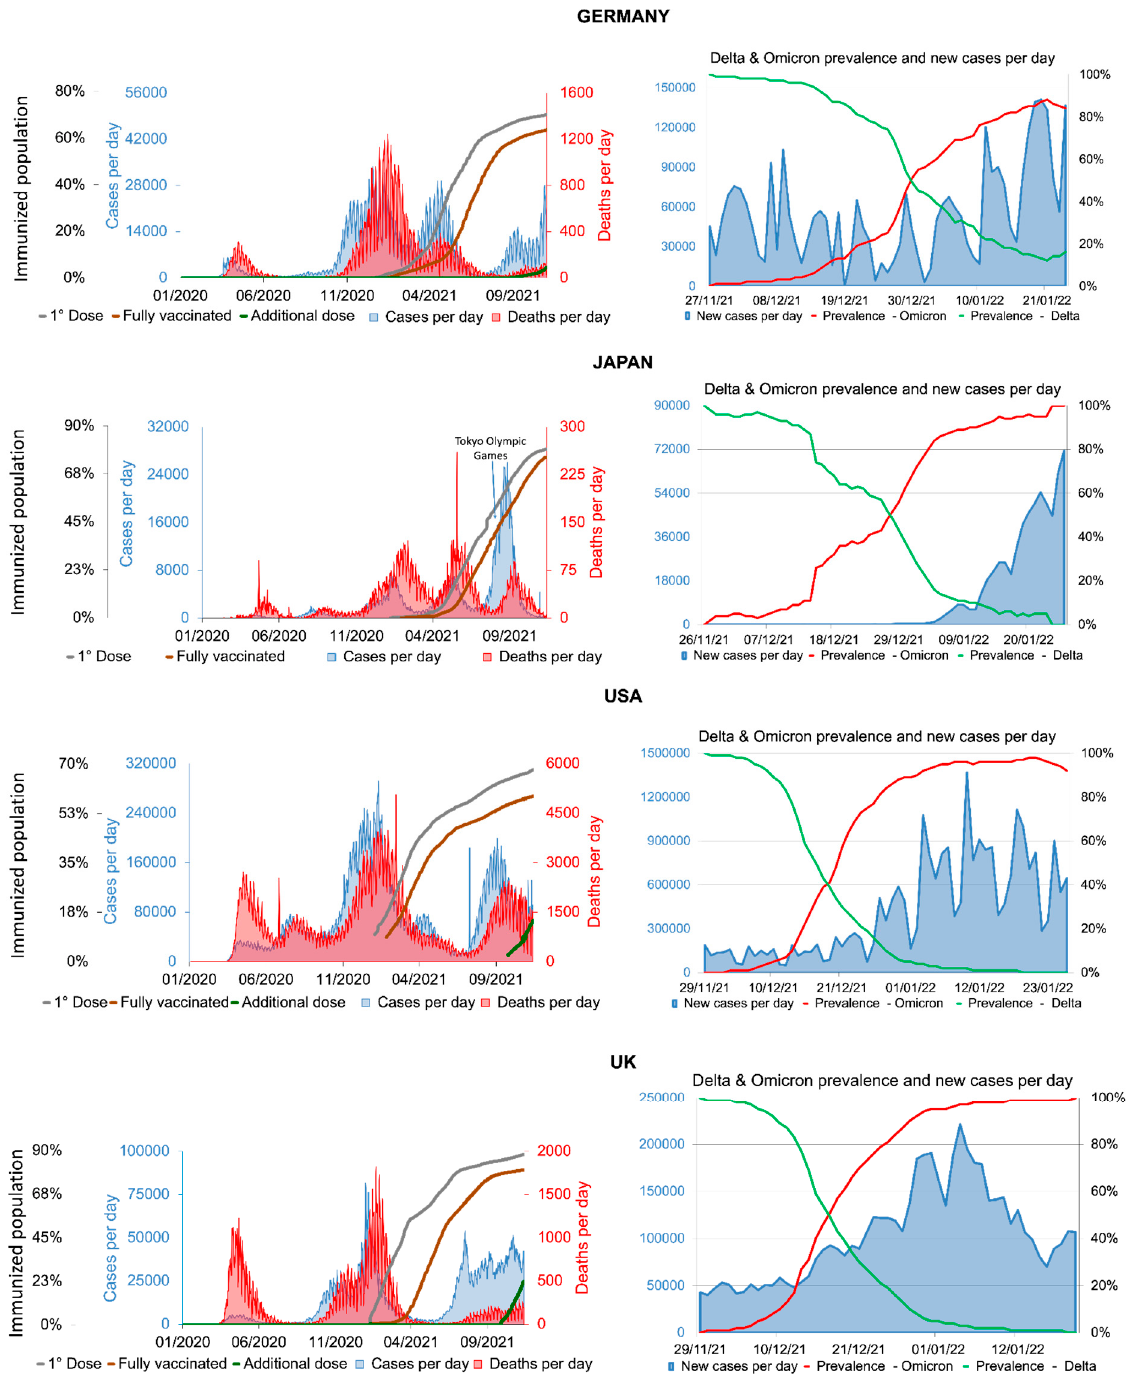
Figure 3. Number of COVID ‐ 19 cases and death rates, the effect of vaccination rate and prevalence of SARS ‐ CoV ‐ 2 Delta and Omicron in the UK, Japan, USA and Germany. The left side shows the number of cases (red line), the number of deaths (blue line), the rate of vaccinated individuals with the first dose (gray line), second dose (fully vaccinated, brown line) and additional dose (green line). The right side shows the graph of the number of cases (blue line) and the percentage of the Delta variant (green line) and Omicron variant (red line) as a function of time. All data were obtained from World in Data, WHO, CDC, UK Gov and Outbreak [1,148–151].